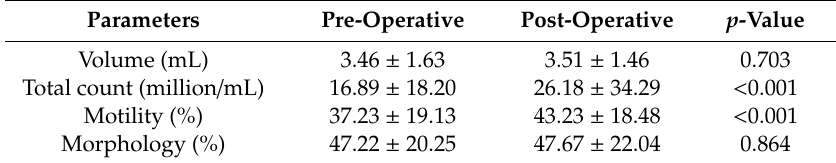
Table 2. Pre- and post-varicocelectomy semen parameters (volume, total count, motility, and